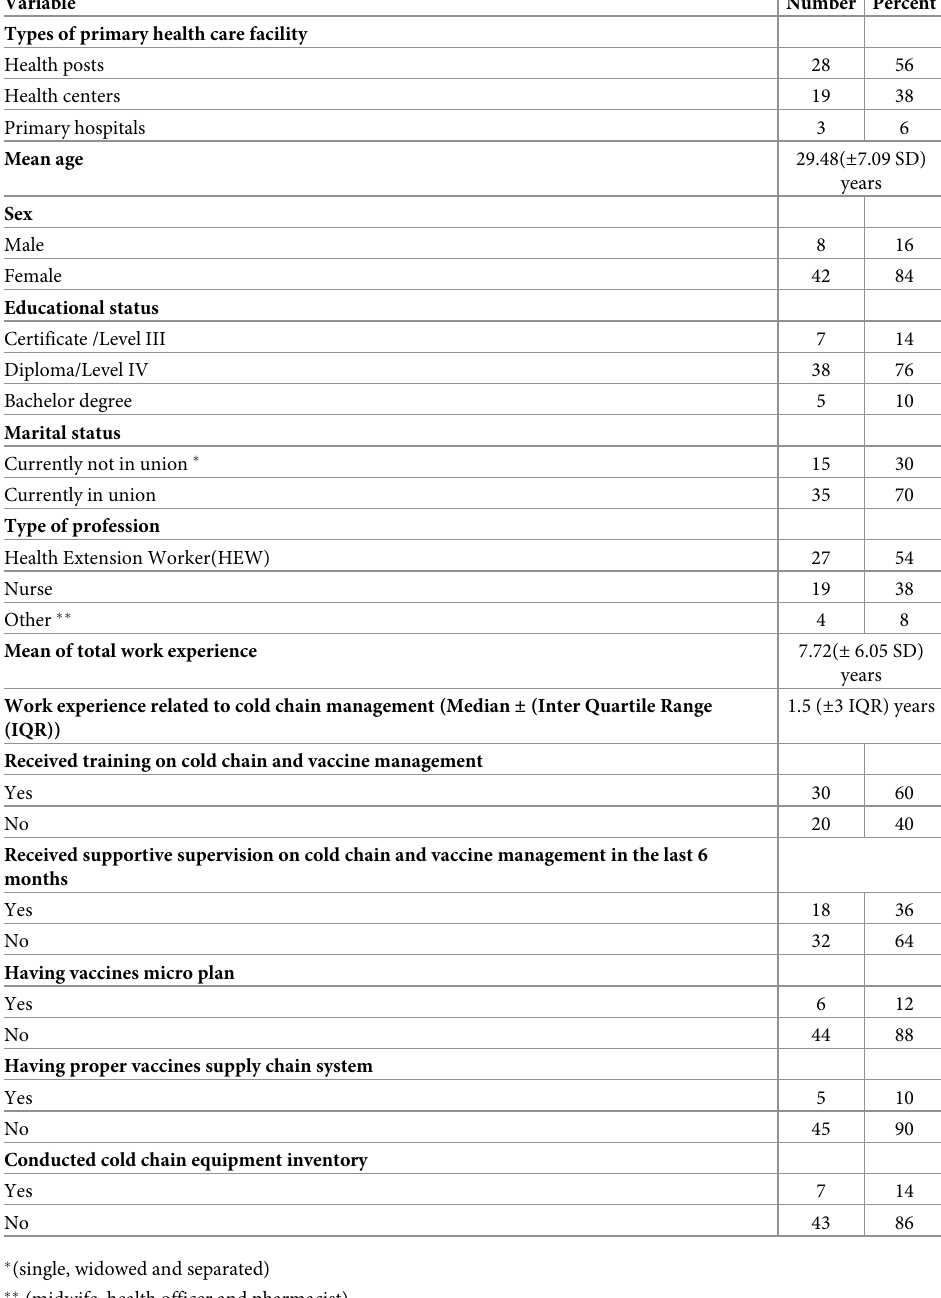
Table 1. Socio-demographic characteristics of PHCFs and respondents in primary health care facilities of Tigray region, Northern Ethiopia, 2019 (N =